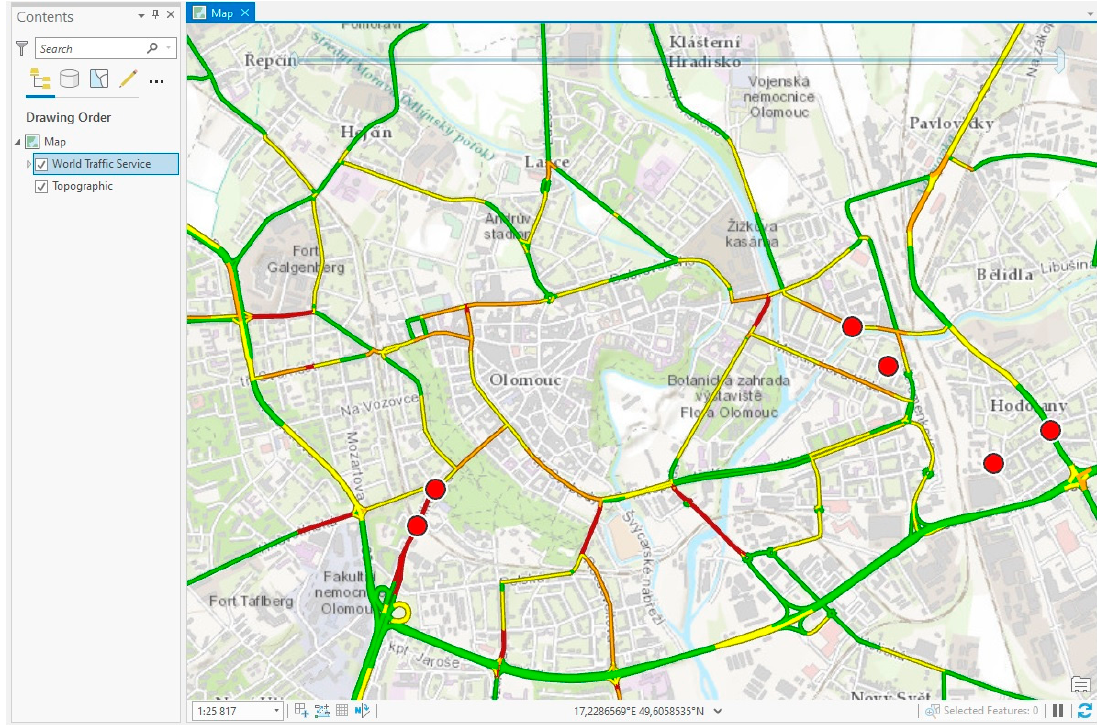
Figure 12. Environmental Systems Research Institute’s (ESRI) World Traffic Service layer displaying the traffic situation in Olomouc.